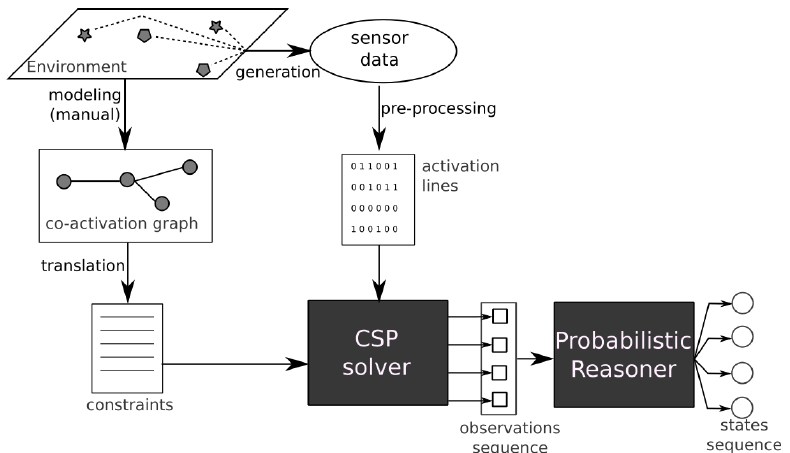
Figure 4. Overview of the person counting module’s architecture. From Reference